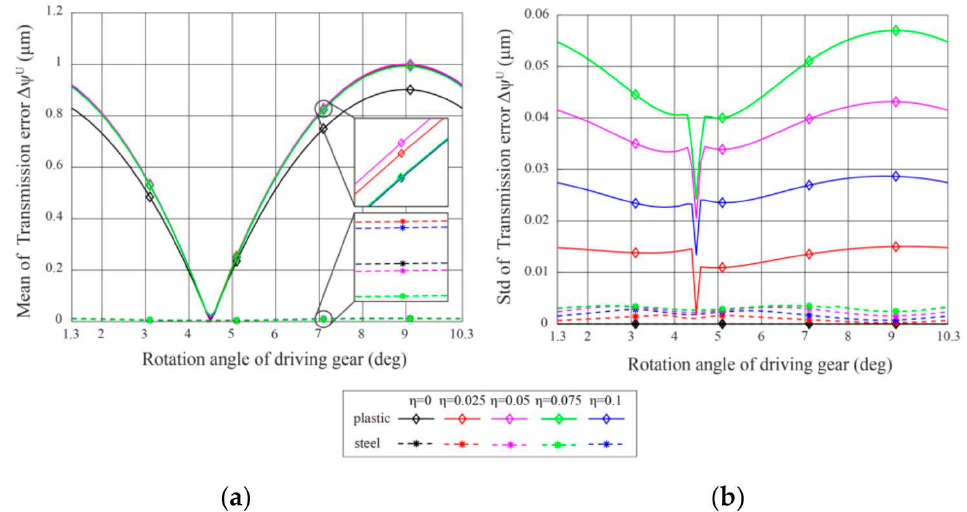
Figure 13. ( a ) Mean and ( b ) standard deviation (std) of transmission error under unloaded condition. When the uncertainty of the material properties ( η ) increases, there is no machining error or pitch error ( (cid:101) = 0, e p = 0 ) .